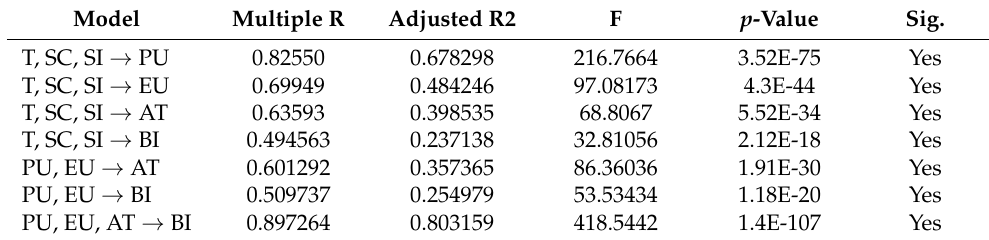
Table 13. Multiple Regression Analysis Results.